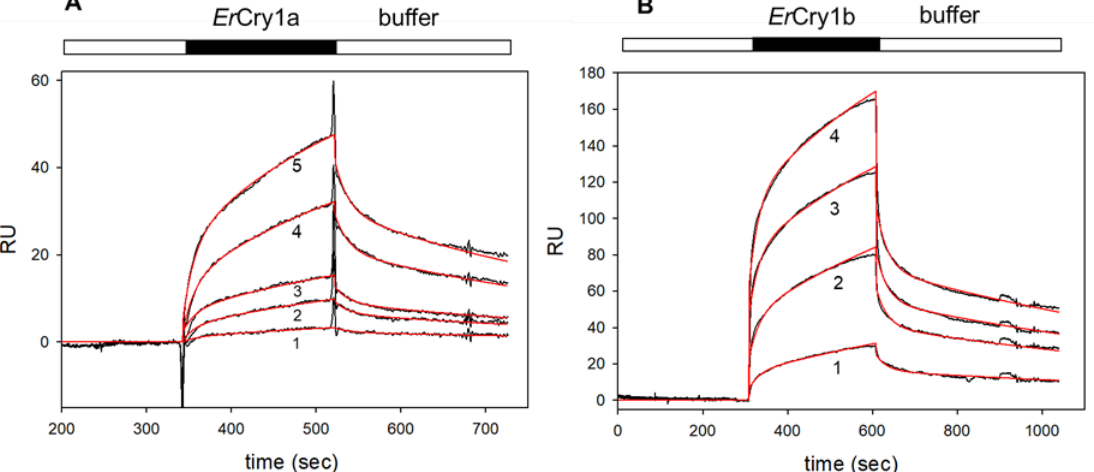
Figure 5. SPR recordings of Er Cry1a and Er Cry1b interacting with immobilized myristoylated G t α/Giα. ( A ) Injection of increasing concentrations of Er Cry1a, 25 nM (1), 35 nM (2), 50 nM (3), 70 nM (4) and 100 nM (5) yielded increasing amplitudes (sensorgrams 1 – 5). Global curve fitting using a two-state-reaction model gave a forward reaction rate k a1 = 1.3 × 10 5 M −1 s −1 and a backward reaction rate k d1 = 5.27 × 10 −2 s −1 , K D = 0.4 µM. ( B ) Injection of increasing concentrations of Er Cry1b, 50 nM (1), 150 nM (2), 300 nM (3) and 400 nM (4) yielded increasing amplitudes (sensorgrams 1 – 4). Global curve fitting using a two-state-reaction model gave a forward reaction rate k a1 = 2.17 × 10 4 M −1 s −1 and a backward reaction rate k d1 = 3.32 × 10 −2 s −1 , K D = 1.53 µM.